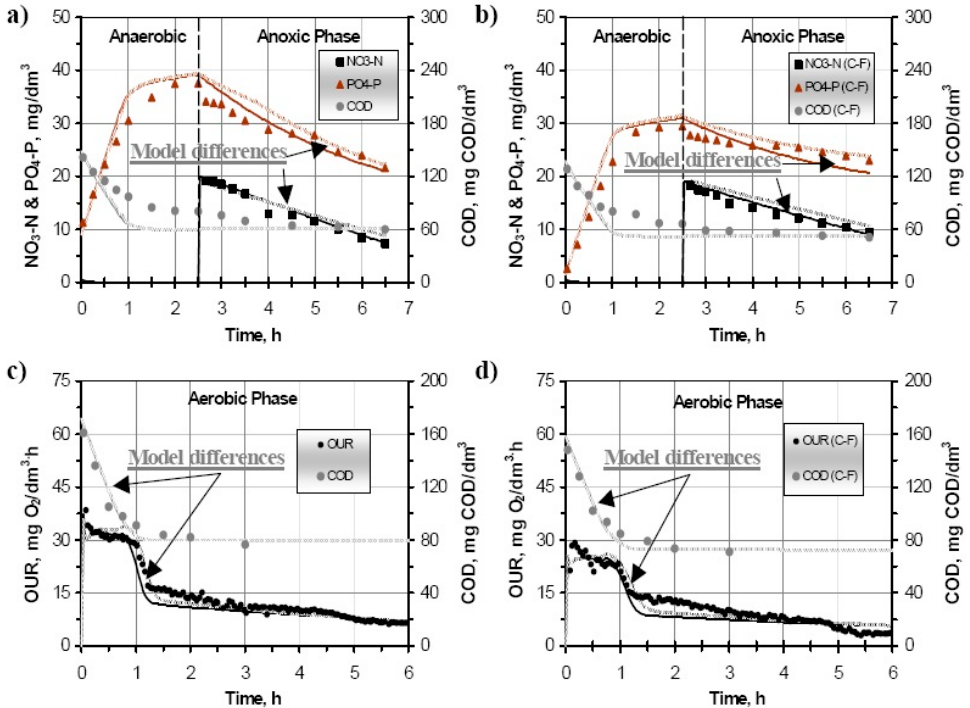
Figure 3. Experimental data and model predictions in the batch test treating SWW without pretreatment and after C–F. Solid lines corresponds to conventional ASM2d predictions and dashed ones to the modified ASM2d predictions. ( a ) PRR/anoxic PUR tests without pretreatment; ( b ) C–F treatment for PRR/anoxic PUR tests; ( c) OUR tests without pretreatment; ( d ) C–F treatment for OUR tests .